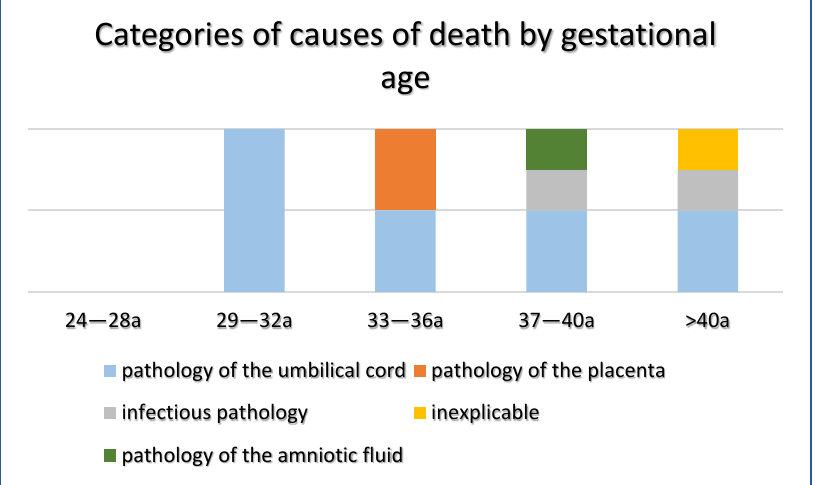
Figure 4. Categories for cause of death by gestational age.